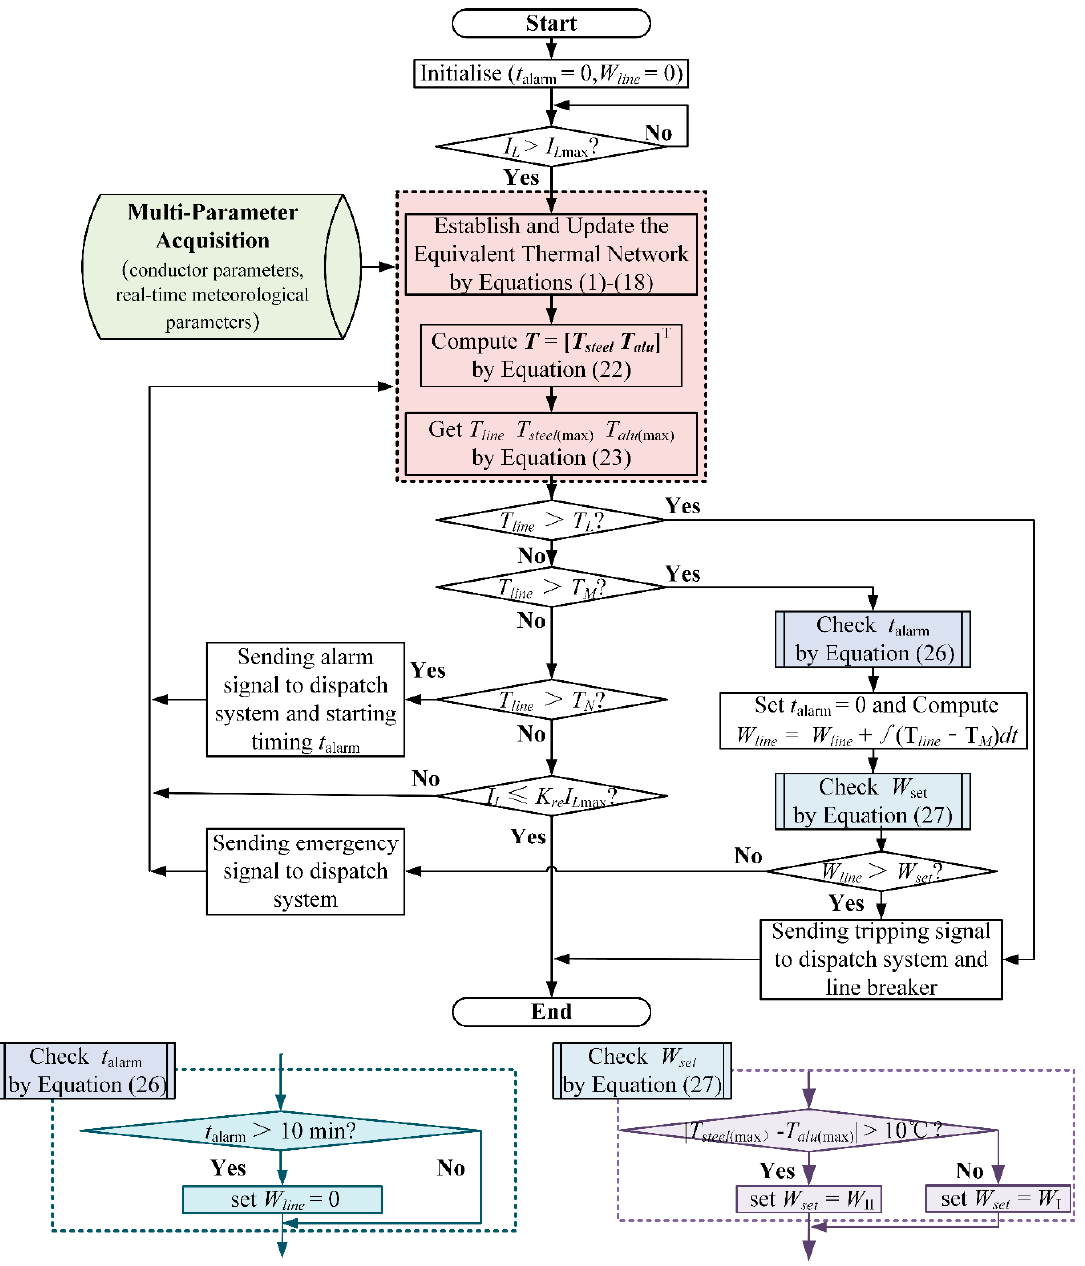
Figure 11. MPTP strategy flowchart of overhead transmission lines.